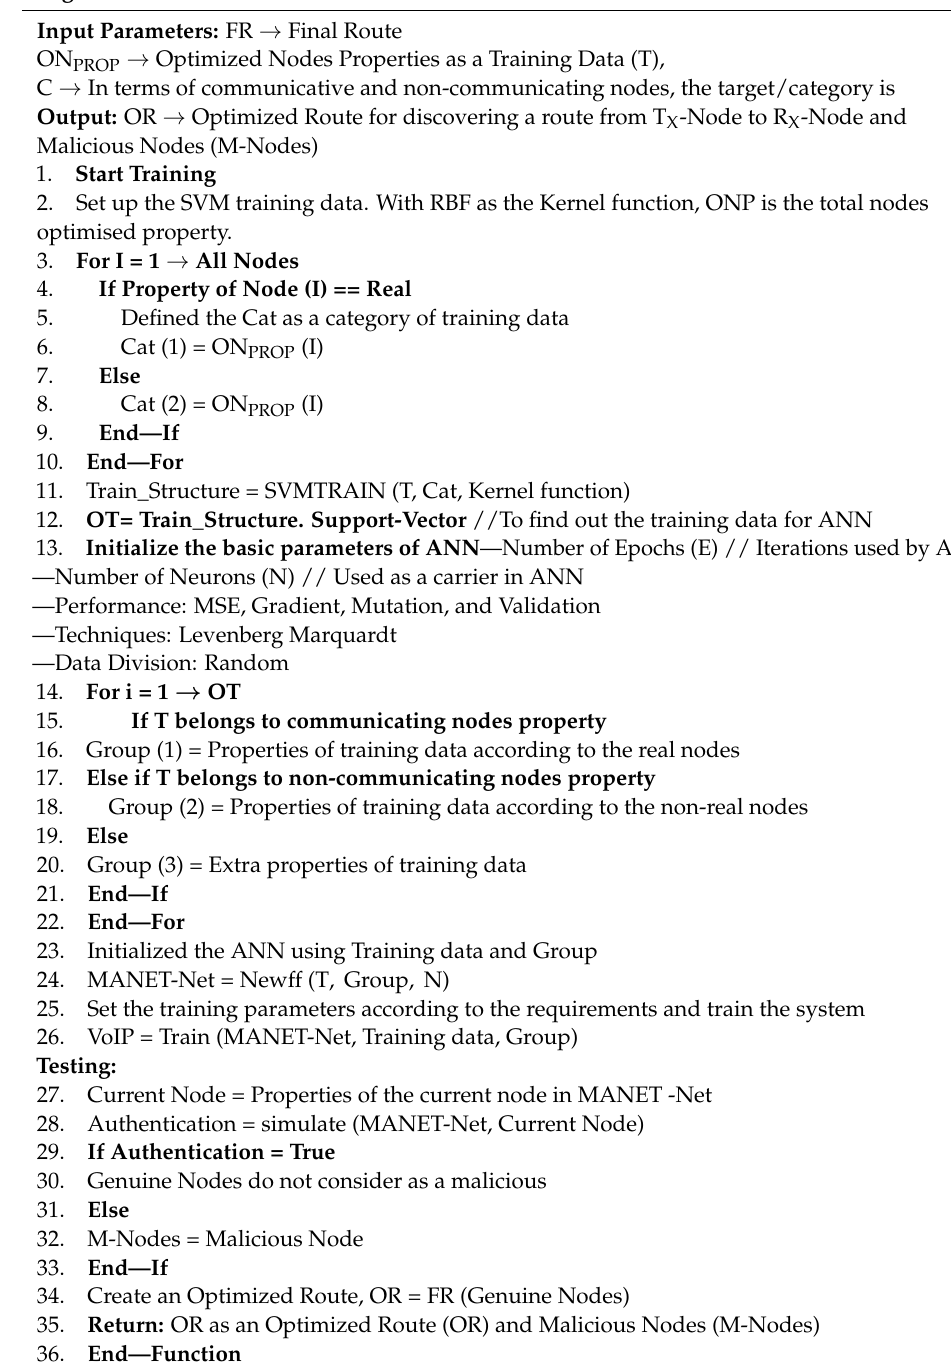
Algorithm 3: SVM with